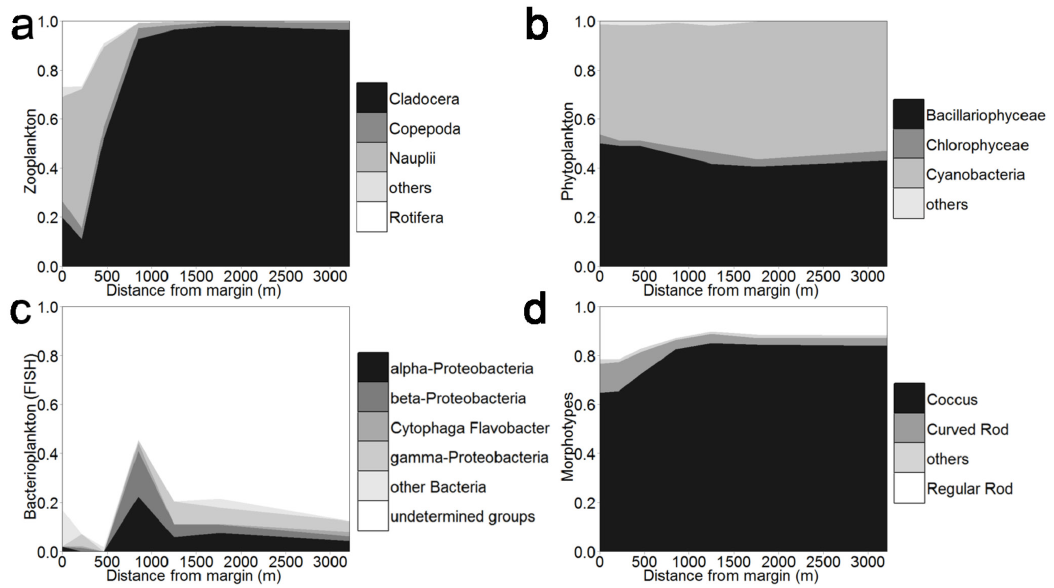
Figure 5. Contribution of major groups of a) zooplankton, b) phytoplankton, c) bacterial phylotypes and d) bacterial morphotypes along a transect running from a macrophyte dominated littoral zone to a phytoplankton dominated pelagic zone in Lake Mangueira. Standard deviations (n =3)